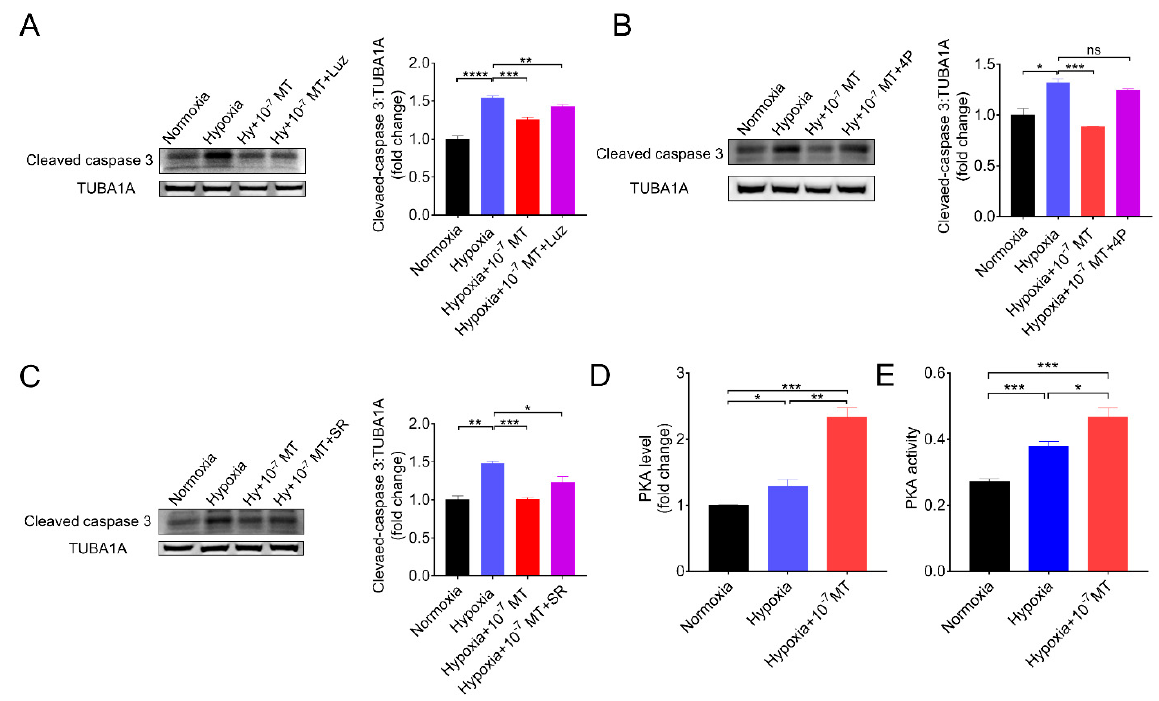
Figure 5. MT inhibited hypoxia-induced GCs apoptosis by binding to its receptor MTNR1B. ( A – C ) The level of cleaved caspase − 3 was determined by Western blotting in GCs cultured in normoxia and hypoxia in the presence of 10 − 7 M MT, Luzindole (Luz) ( A ), 4P-PDOT (4P) ( B ), or SR1001 (SR) ( C ). ( D , E ) The determination of PKA concentration ( D ) and activity ( E ) in normoxia, hypoxia, and hypoxia plus 10 − 7 M MT. * p < 0.05 was considered significant; ** p < 0.01 was considered highly significant; *** p < 0.001 was considered very significant; **** p < 0.0001 was considered extremely significant; ns p > 0.05 was considered no significant.